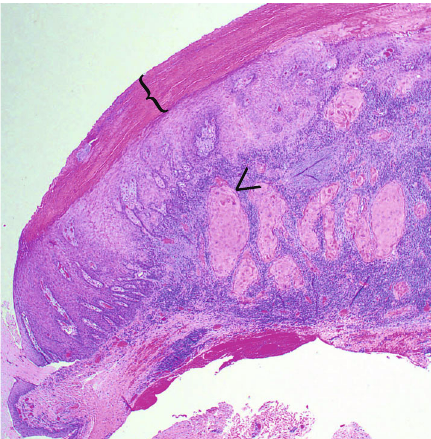
Figure 3: Lateral limbal lesion from a cow. Photomicrograph of the specimen showing the plaque-like exophytic neoplasm that replaced that conjunctival and corneal epithelium. The cells formed sheets and anastomosing lobules, which multifocally invade below the basement membrane (arrow). The super fi cial surface of the mass was composed of dense keratin (bracket). In fl ammatory cells heavily in fi ltrated the underlying stroma. The margins were clear of neoplastic cells. Hematoxylin and